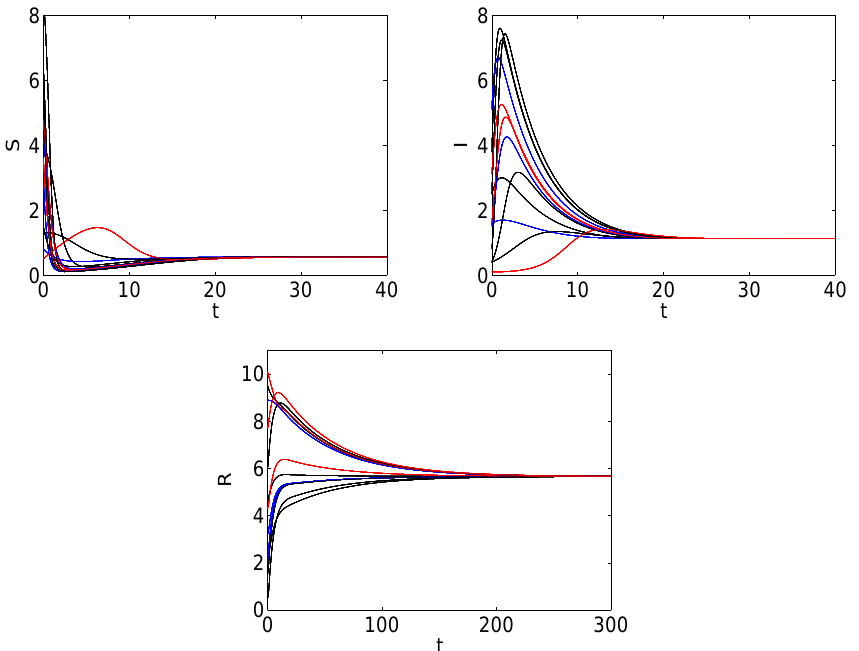
Figure 5. Variational curves of S , I , and R with time t when R 3 = 5.0649 > 1 for the same initial values and parameters of Figure 2 except q = δ =